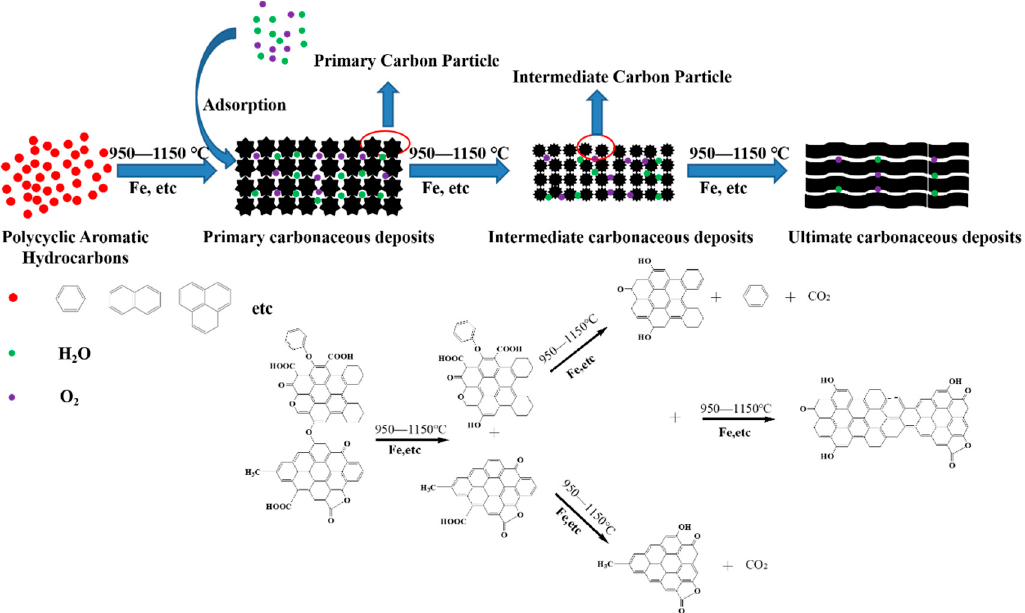
Figure 11. Schematic illustration for the formation and evolution mechanism for carbonaceous deposits